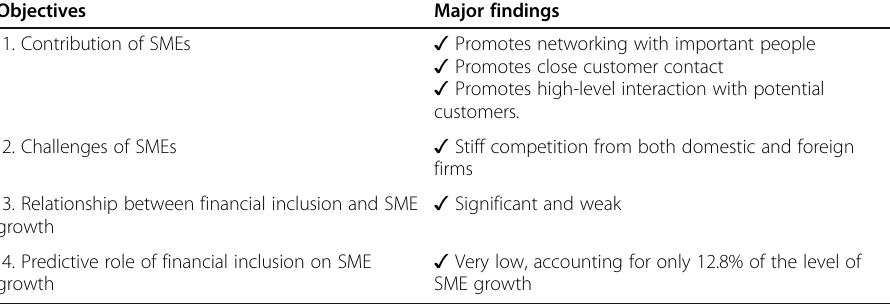
Table 12 Summary of findings